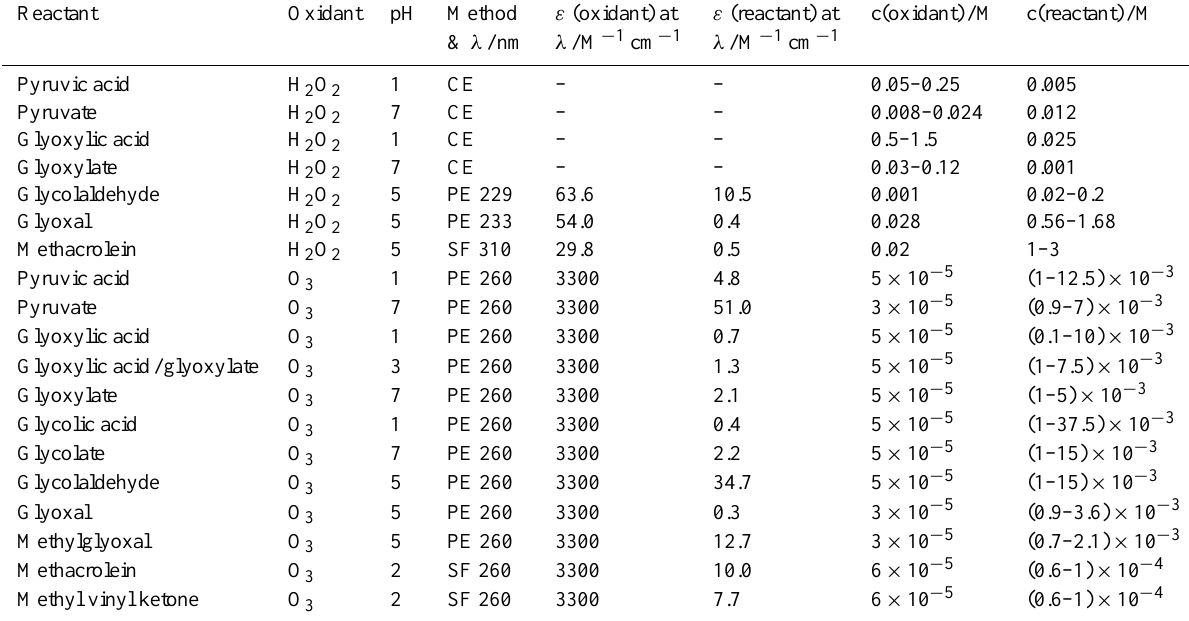
Table 1. Experimental details.